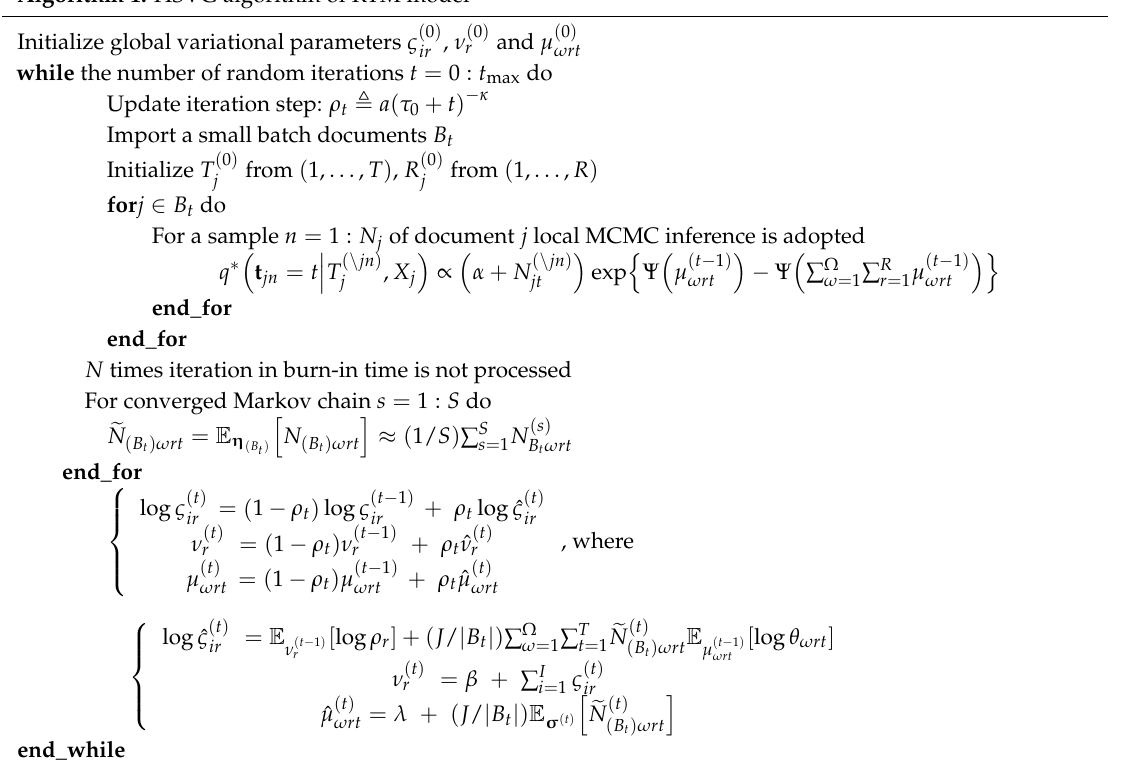
Algorithm 1. HSVG algorithm of RTM